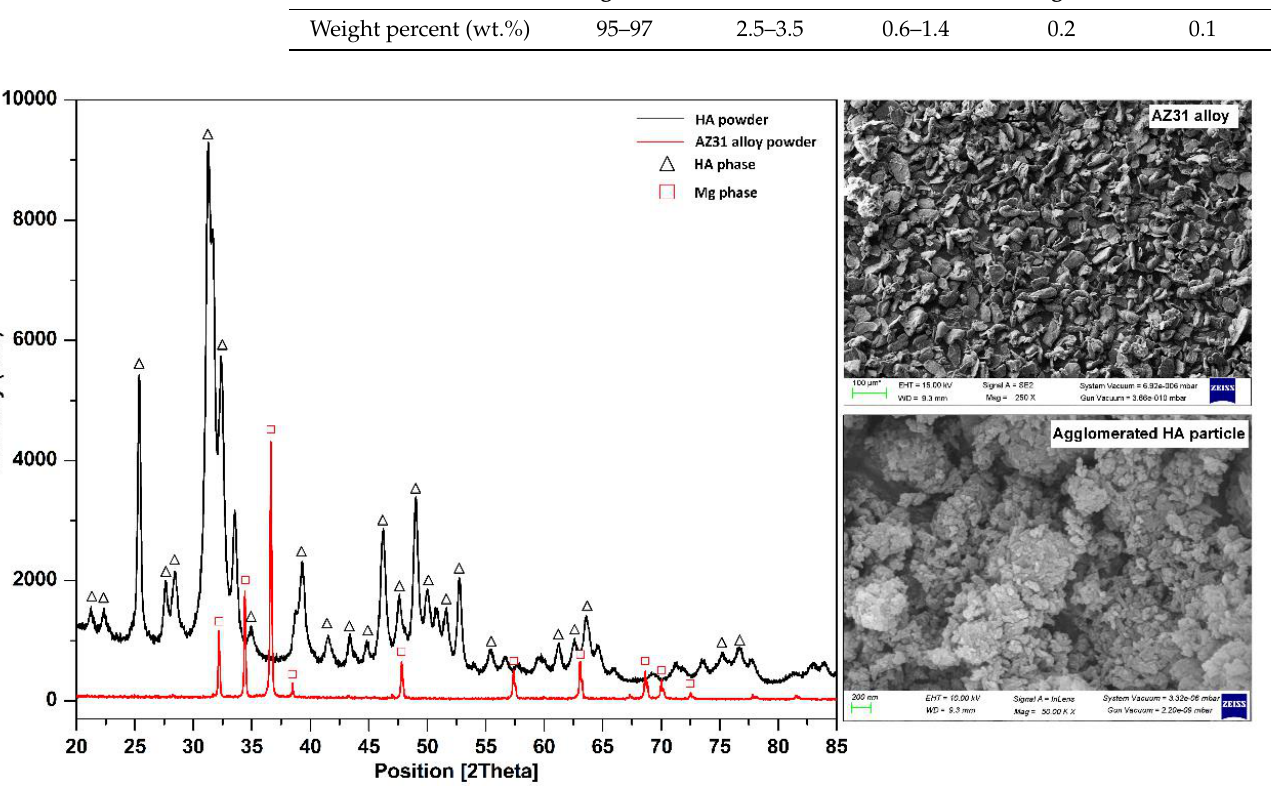
Figure 1. XRD spectra of AZ31 alloy and HA powder (Inset: SEM micrograph of AZ31 alloy powder particles (100 µm scale) and agglomerated HA powder particles (200 nm scale)). Table 1. Chemical composition of AZ31 alloy.